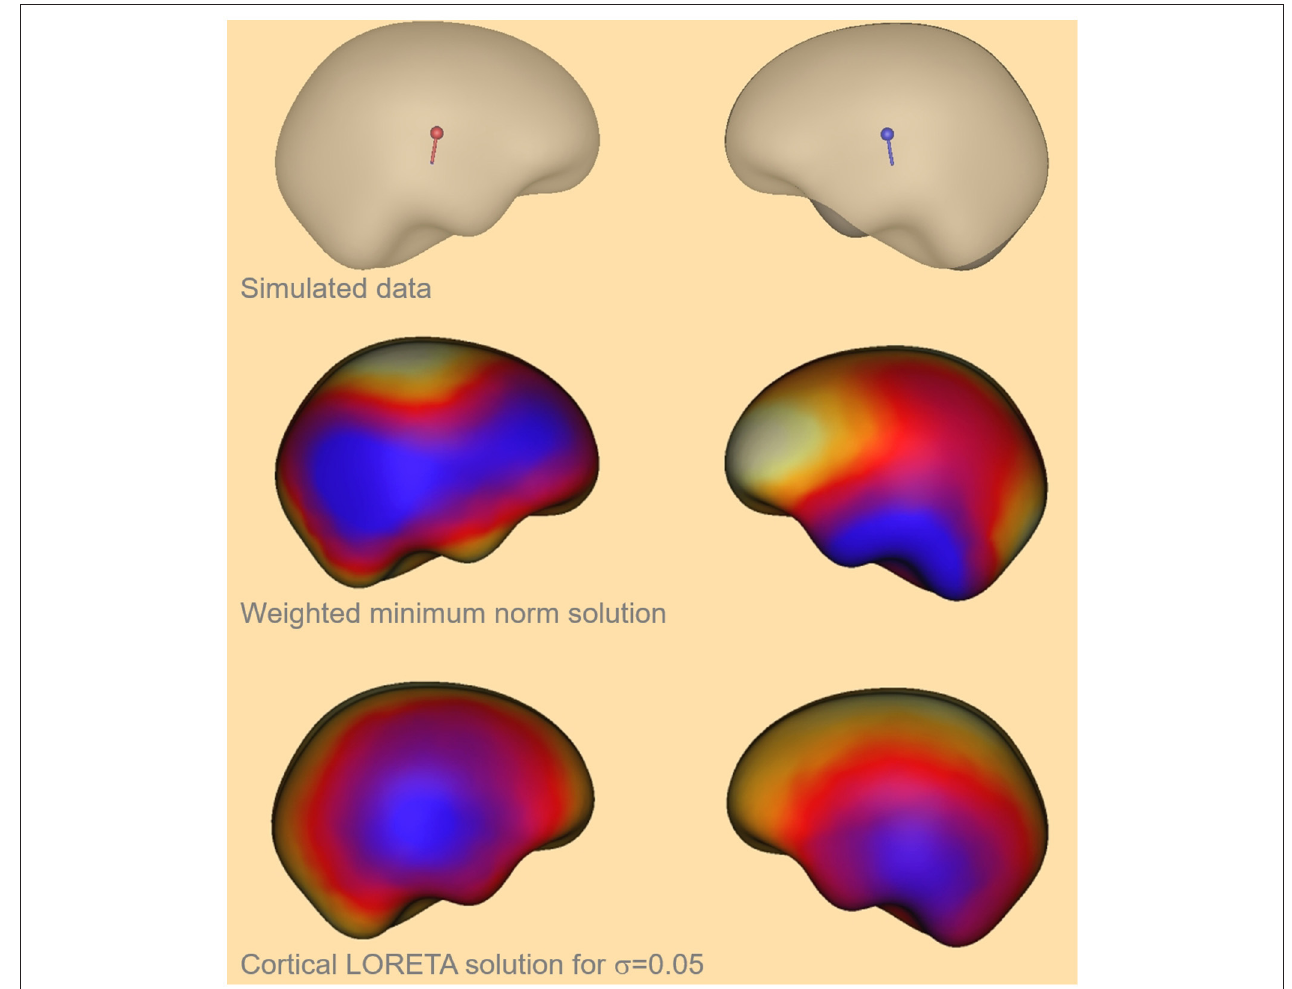
FIGURE 4 | Visual comparison of the simulated auditory sources (top), the depth weighted minimum-norm solution (center) and the cortical LORETA solution (bottom) for the optimal value of σ .